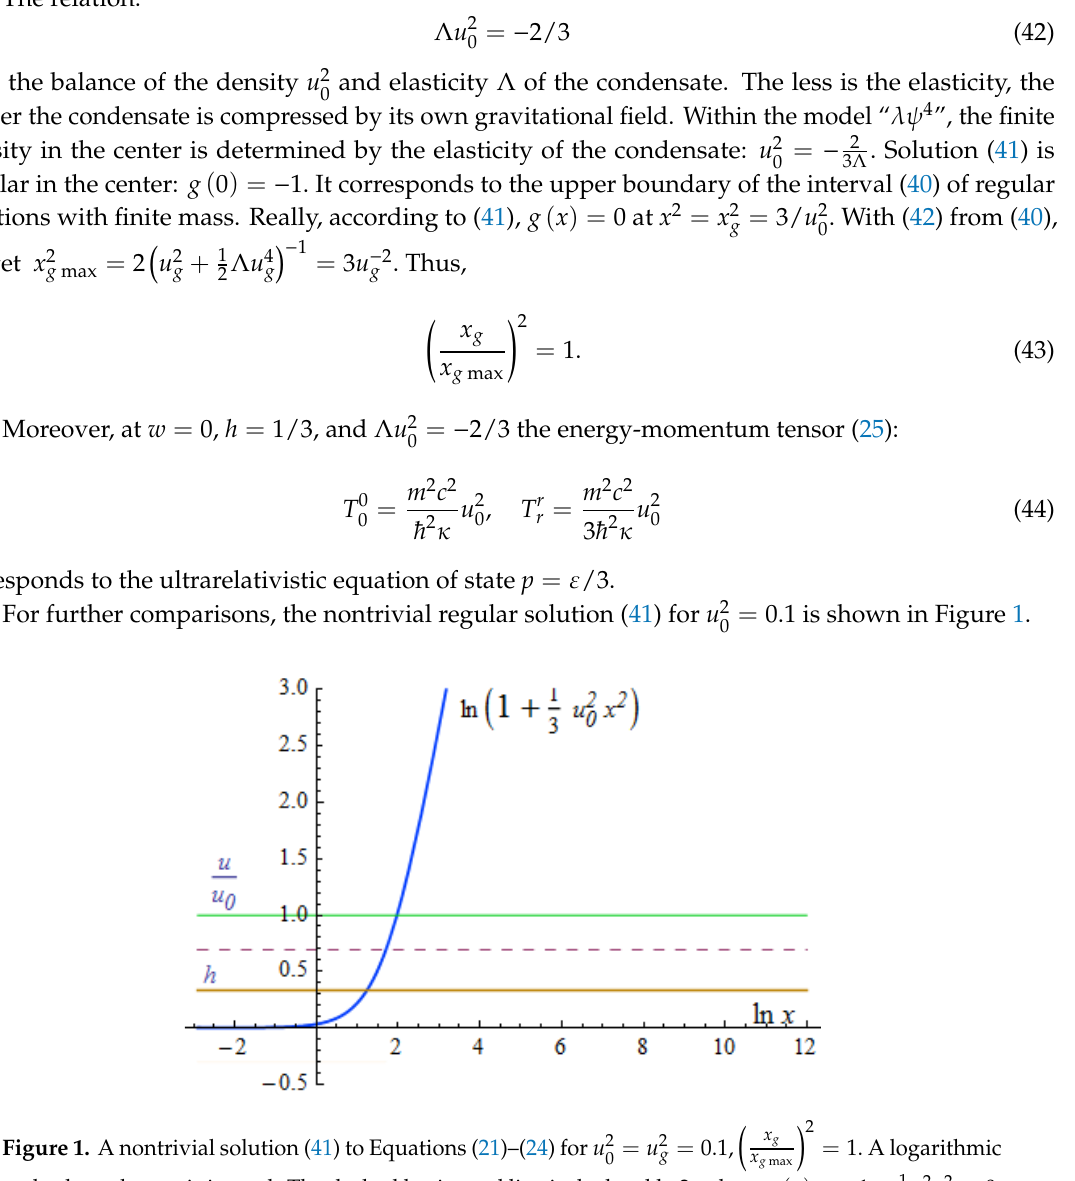
Figure 1. A nontrivial solution (41) to Equations (21)–(24) for u 2 , where g ( x ) = − 1 + 1 A logarithmic scale along the x axis is used. The dashed horizontal line is the level ln 2 ;